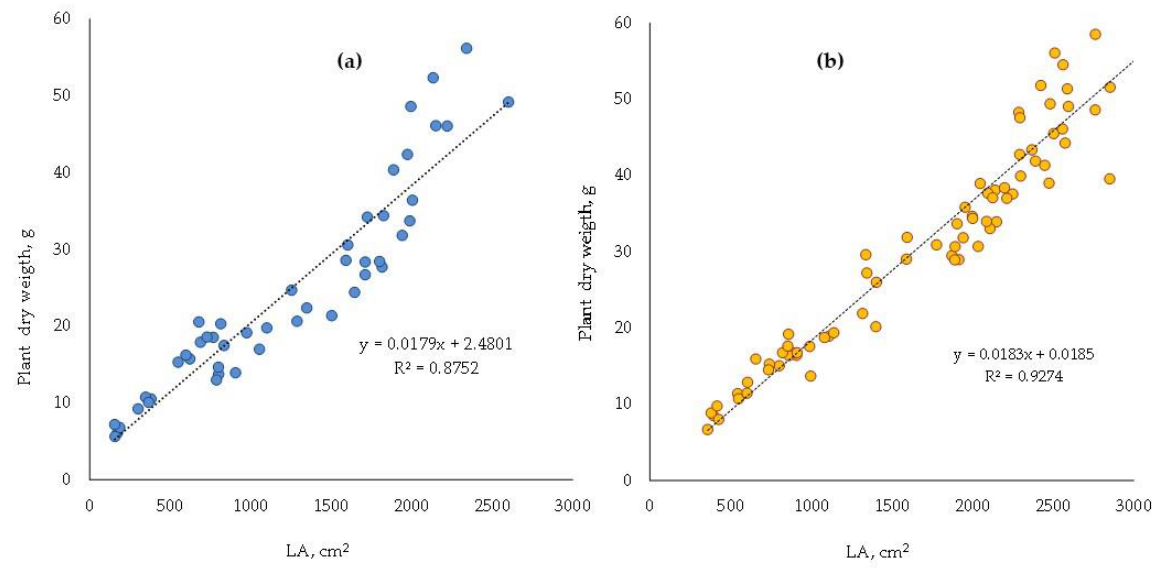
Figure 2. Relationship between plant leaf area (LA, cm 2 ) and dry weight (DW, g) in the first ( a ) (left) and the second-year ( b ) (on the right) trials.